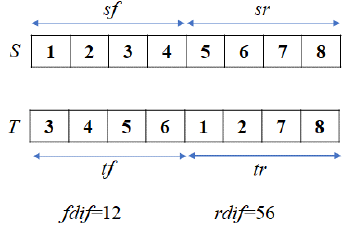
Figure 5. Setup in LS 8 .